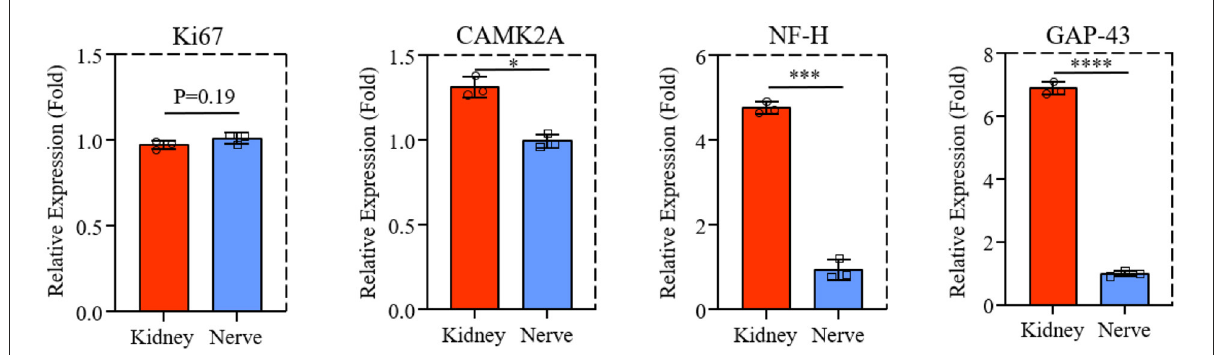
FIGURE5 The qPCR result of Ki67, CAMK2A, NF-H, and GAP-43 expression of PC-12 cells cultured on dK and dN. * P ≤ 0.05, *** P ≤ 0.001, and **** P ≤